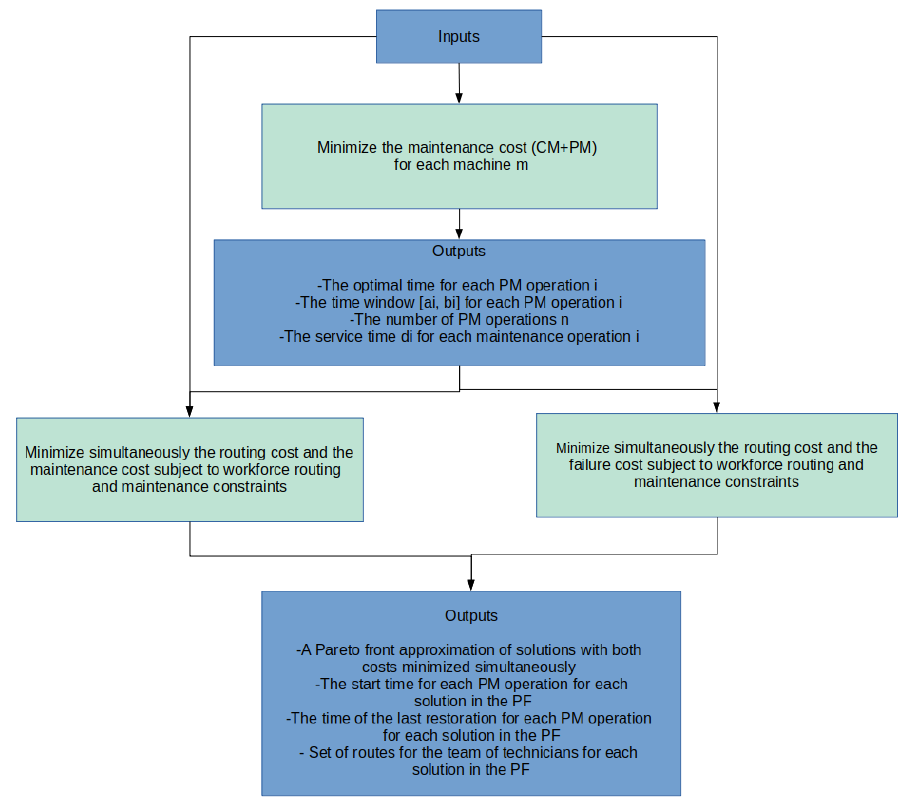
Figure 1. The general